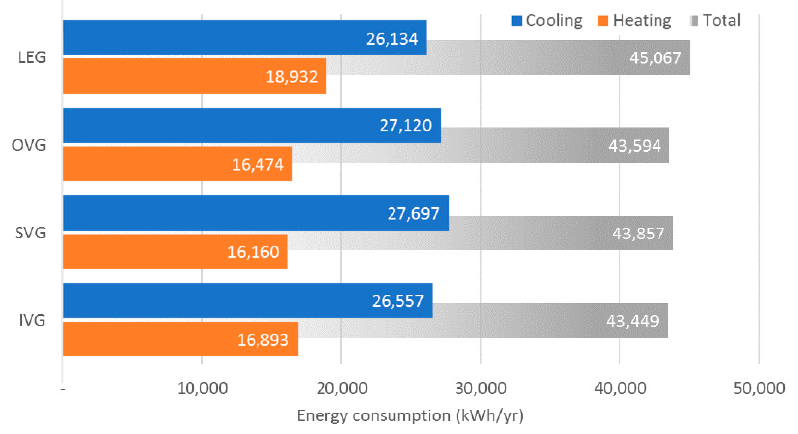
Figure 14. Calculated cooling and heating energy consumption of office buildings.